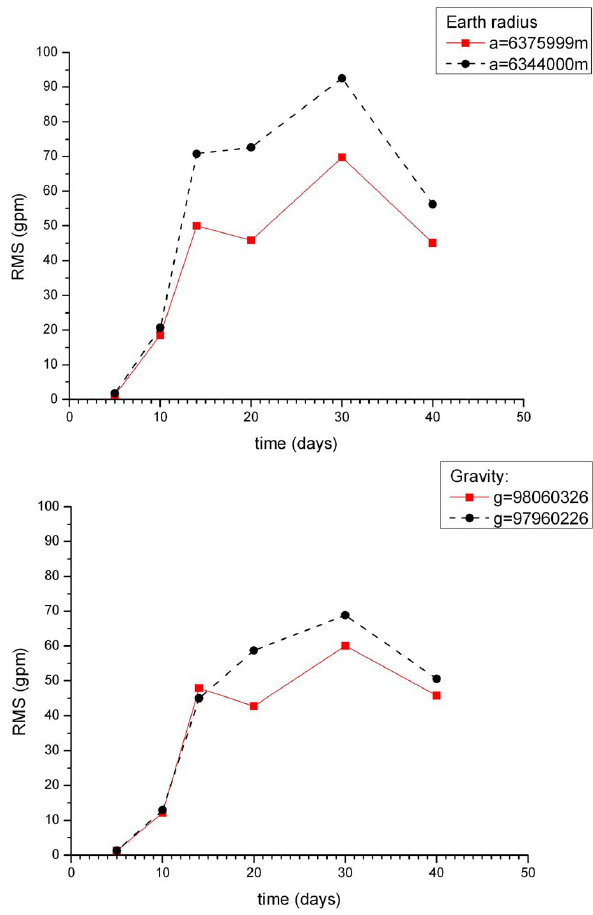
Figure 3. RMS differences for small changes of Earth radius (top) and gravity (bottom) as indicated in the legend.